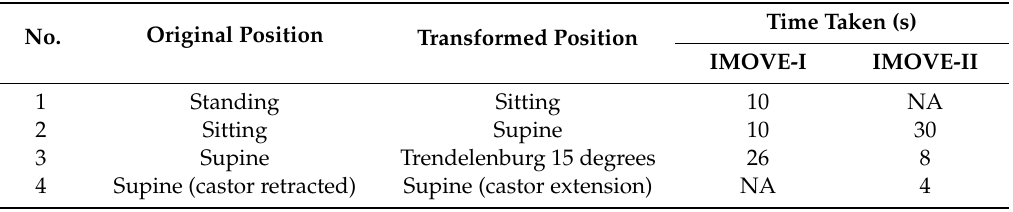
Table 1. Transition time between positions. NA; not